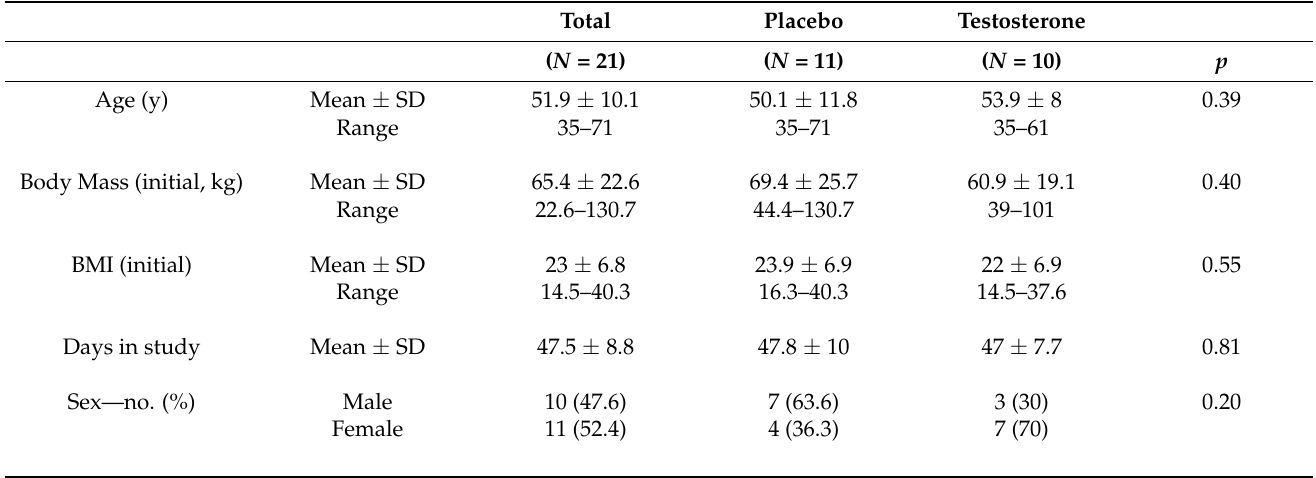
Table 1. Demographics of cervical or head and neck cancer patients receiving 7 weeks of adjunct testosterone or